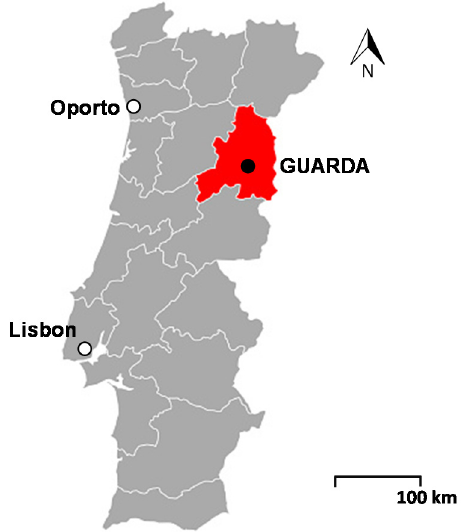
Figure 1. Location of the studied dwellings in Guarda, Portugal.